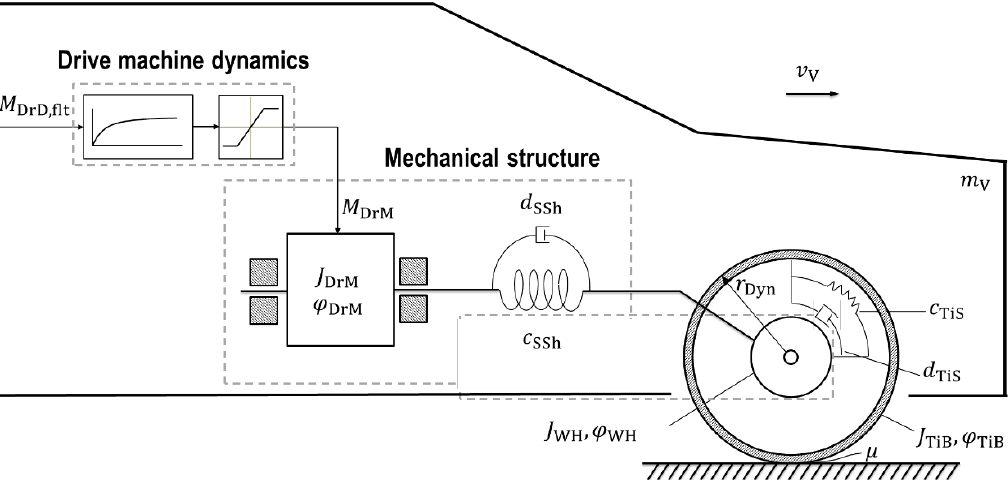
Figure 8. Simplified system visualization of an electrified vehicle drive system.